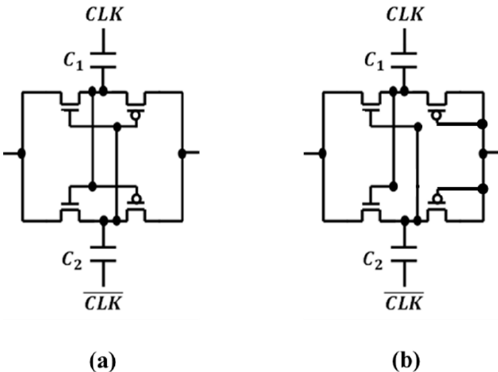
Figure 3. Reconfigurable CP with variable topology of CTSs; CMOS latch CTS in a low input power range ( a ) and a hybrid CTS n a high input power range ( b ).